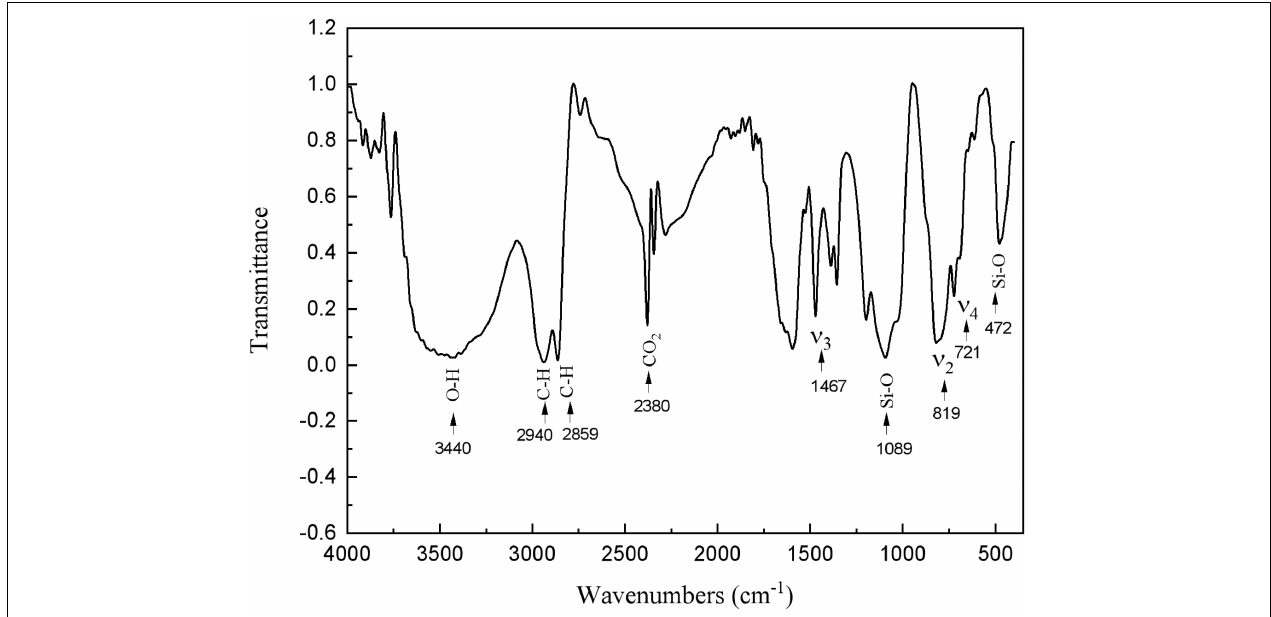
FIGURE 6 | Fourier transform infrared spectroscopy (FTIR) spectra of HDTMS/calcite coating.